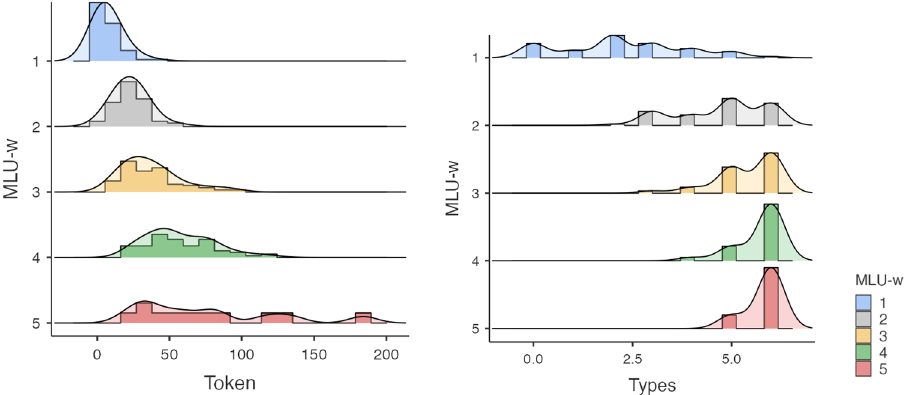
Figure 4. Histogram representing the raw number of word tokens and word types of Article-determiners according to MLU-w e.g., la/le/un/les/l’/une . ‘the, a’.